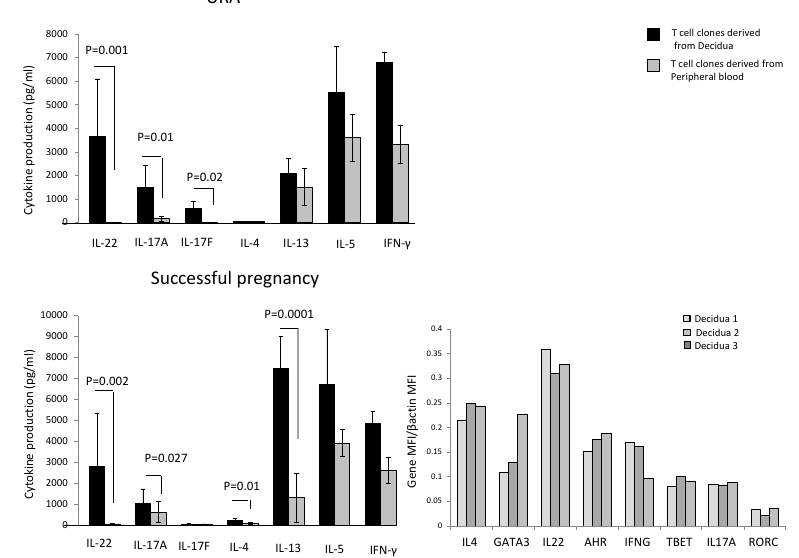
Figure 1. Cytokine production by CD4+ T cell clones derived from decidua of those experiencing successful pregnancy and URA and mRNA expression of cytokines and transcription factors in decidual biopsies of successful pregnancy. CD4+ T cell clones were generated from decidual biopsies, and peripheral blood was obtained from those experiencing successful pregnancy and those experiencing unexplained recurrent abortion (URA) (Experiment 1 in Section 4.3). IL-4, IL-13, IL-5, IL-17A, IL-17F, IL-22, and IFN- γ were measured in the supernatant of the CD4+ T cell clones by a multiplex bead-based assay. The statistical analysis was performed with the Wilcoxon test. The determination of mRNA level for IL-4, GATA-3, IL-17A, ROR-C, IL-22, AHR, T-bet, and IFN- γ in three biopsies of decidua from three pregnant women (with successful pregnancy) was performed by Quantigene